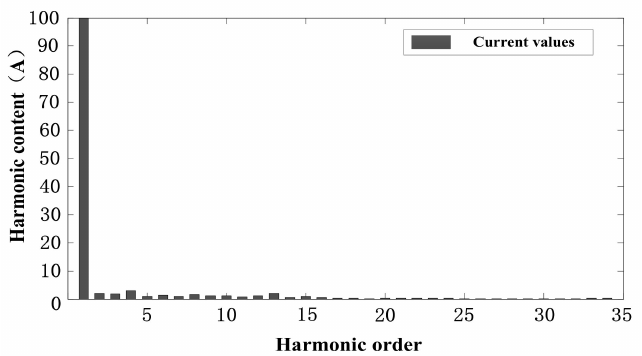
Figure 14. The low-order current harmonics of GSC in super-synchronous